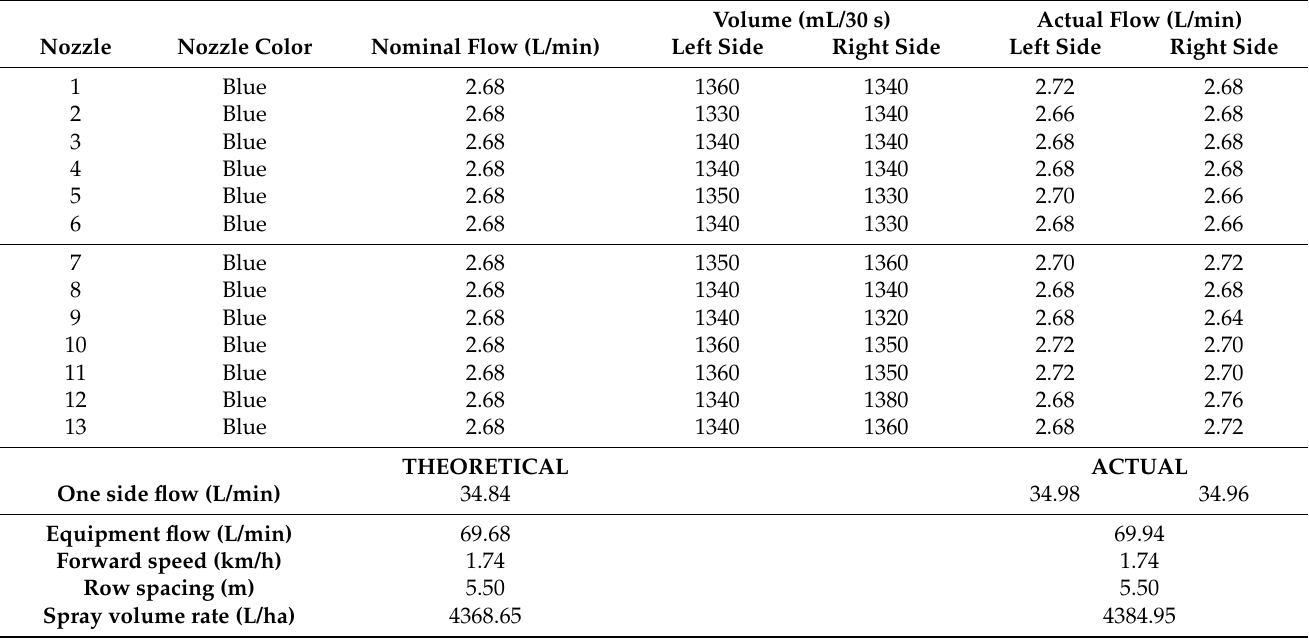
Table A16. Selection and calibration of nozzles for the C2 sprayer, with the following configuration: No adjusted to the vegetation/High & Low fan speed/High spray volume rate/Drift-reducing nozzles (Coarse)/Pressure: 15